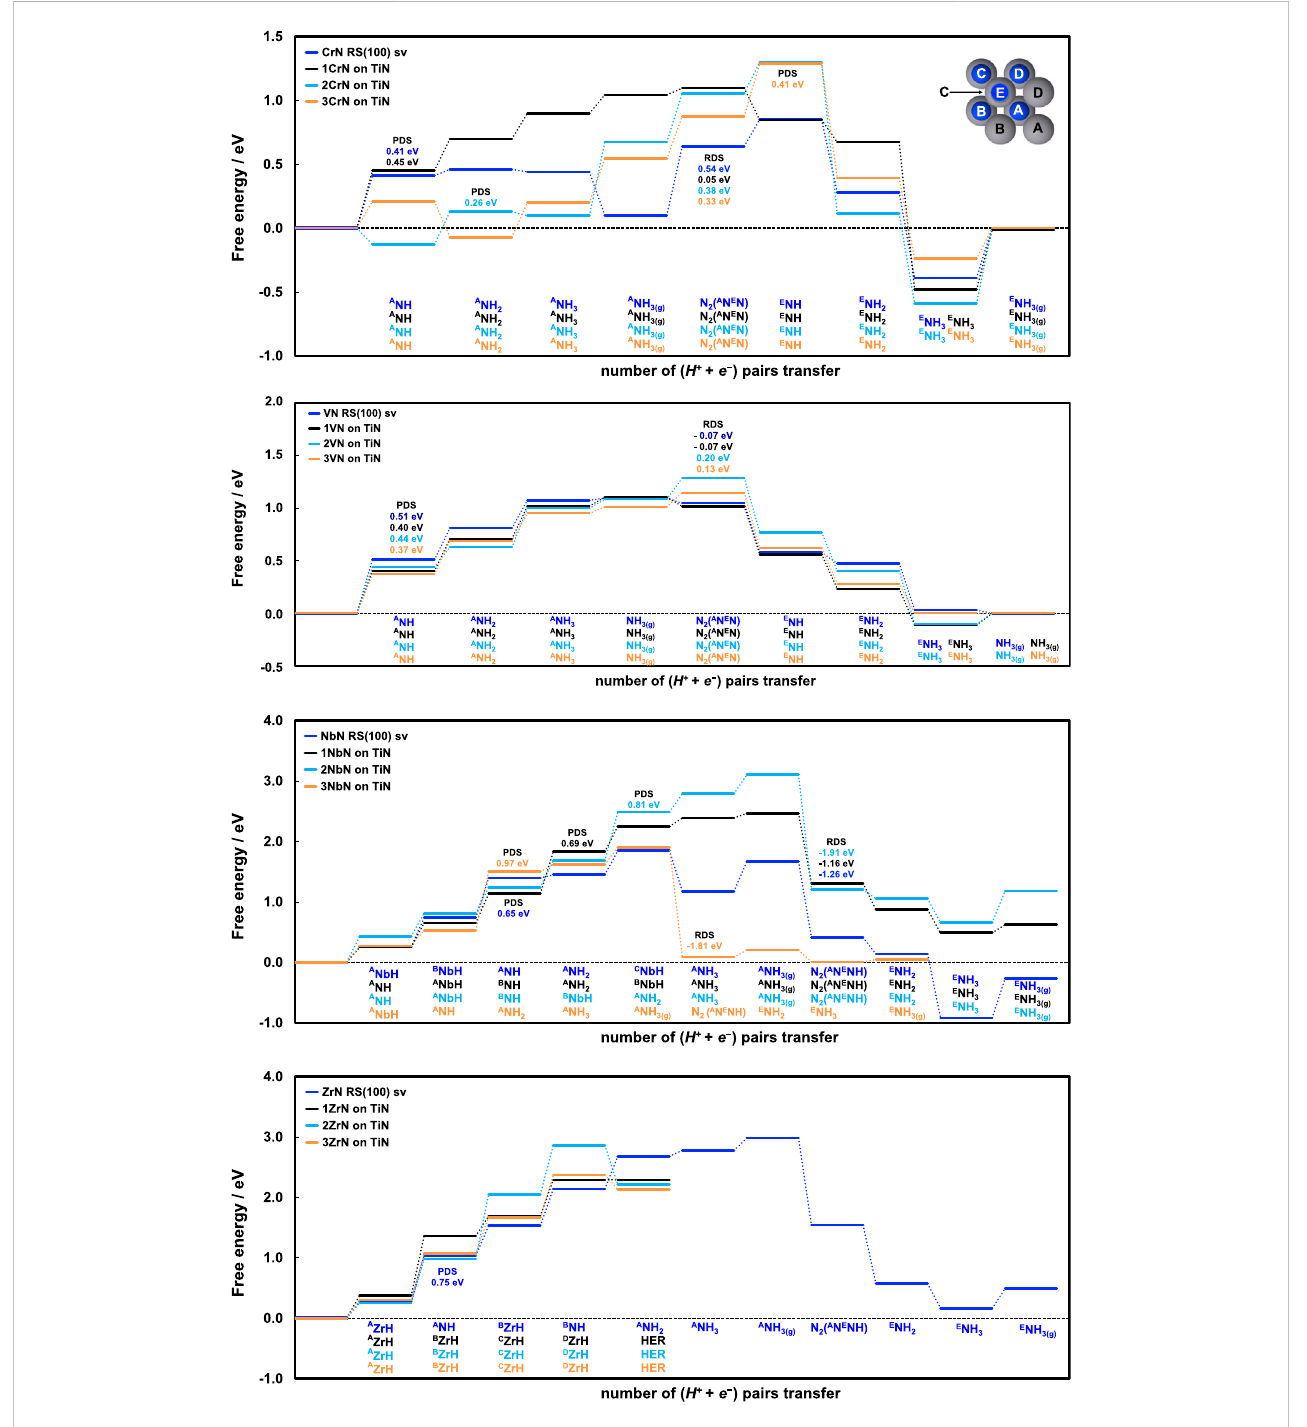
FIGURE 3 FreeenergydiagramsforCrN,VN,NbN,andZrNaspureTMNandwhencombinedwiththestableTiNassubstratewithdifferentnumberofmonolayers.